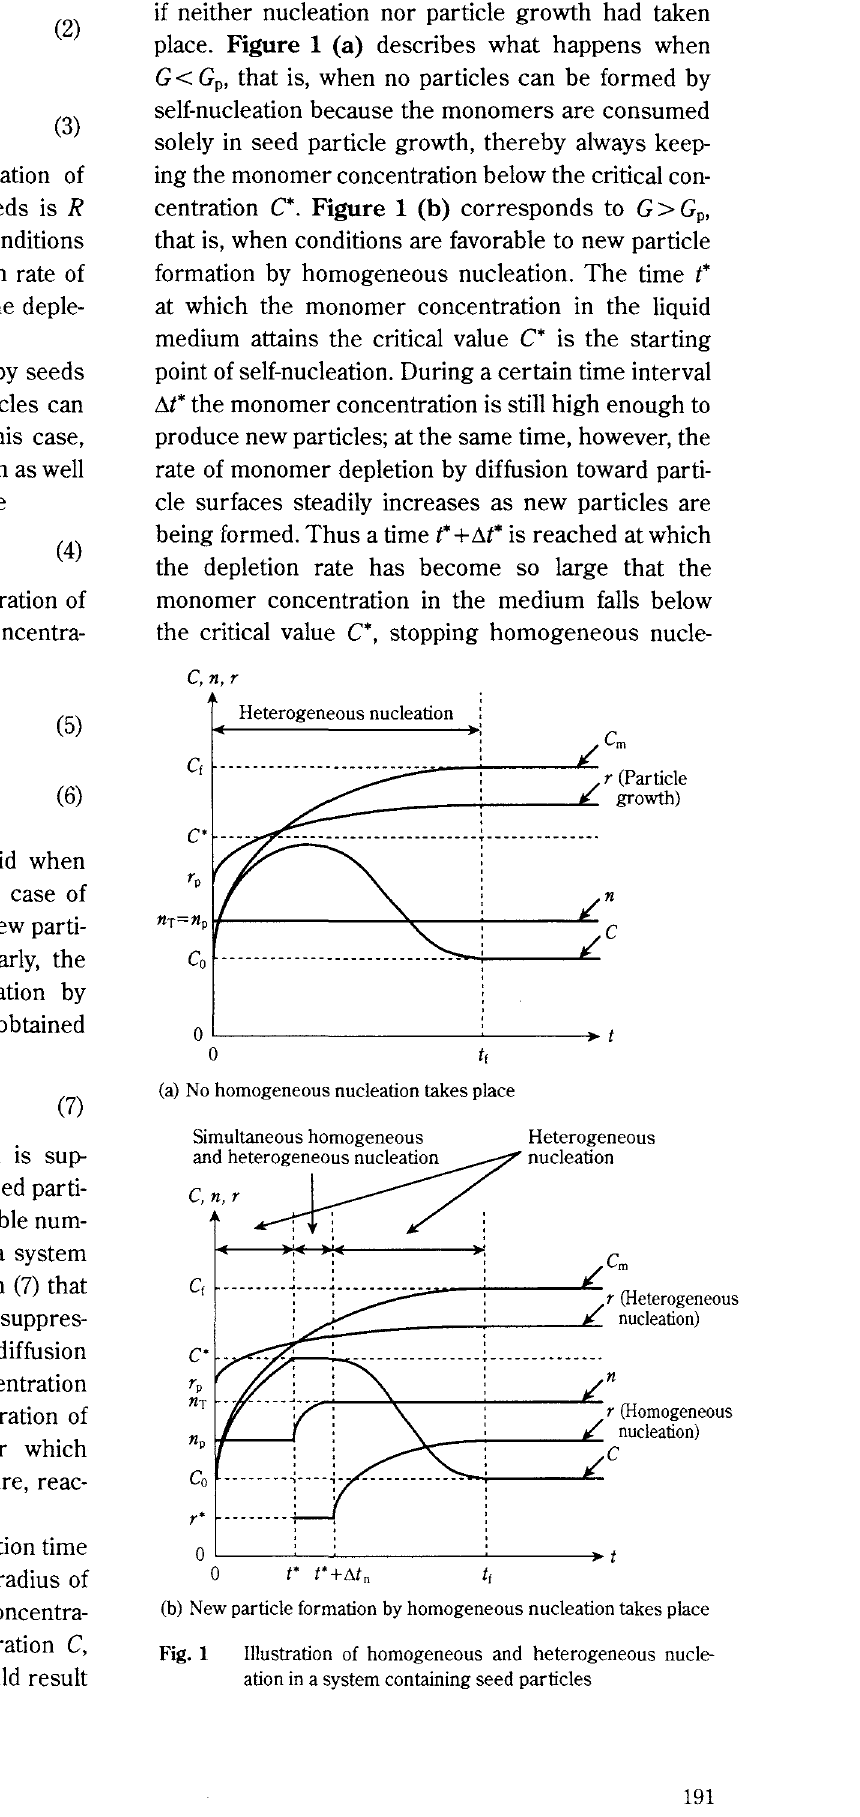
Fig. 1 Illustration of homogeneous and heterogeneous nucle ation in a system containing seed particles